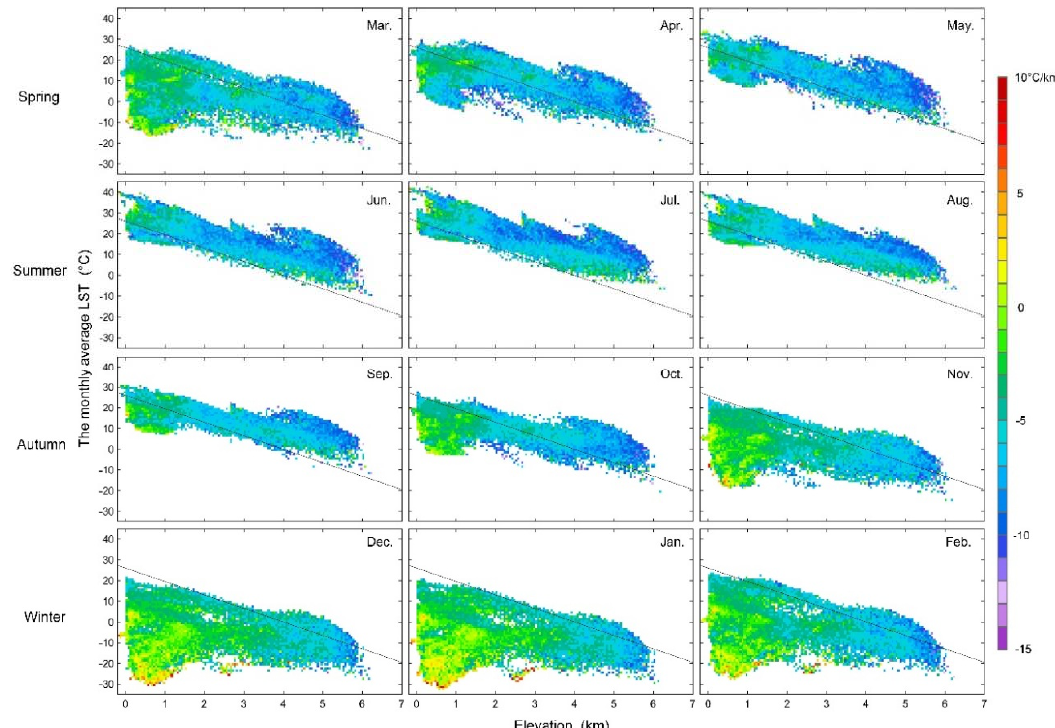
Figure 10. As Figure 9a but of the monthly average TLR with elevation and the monthly average LST. The color bar is the same as that in Figure 9a.